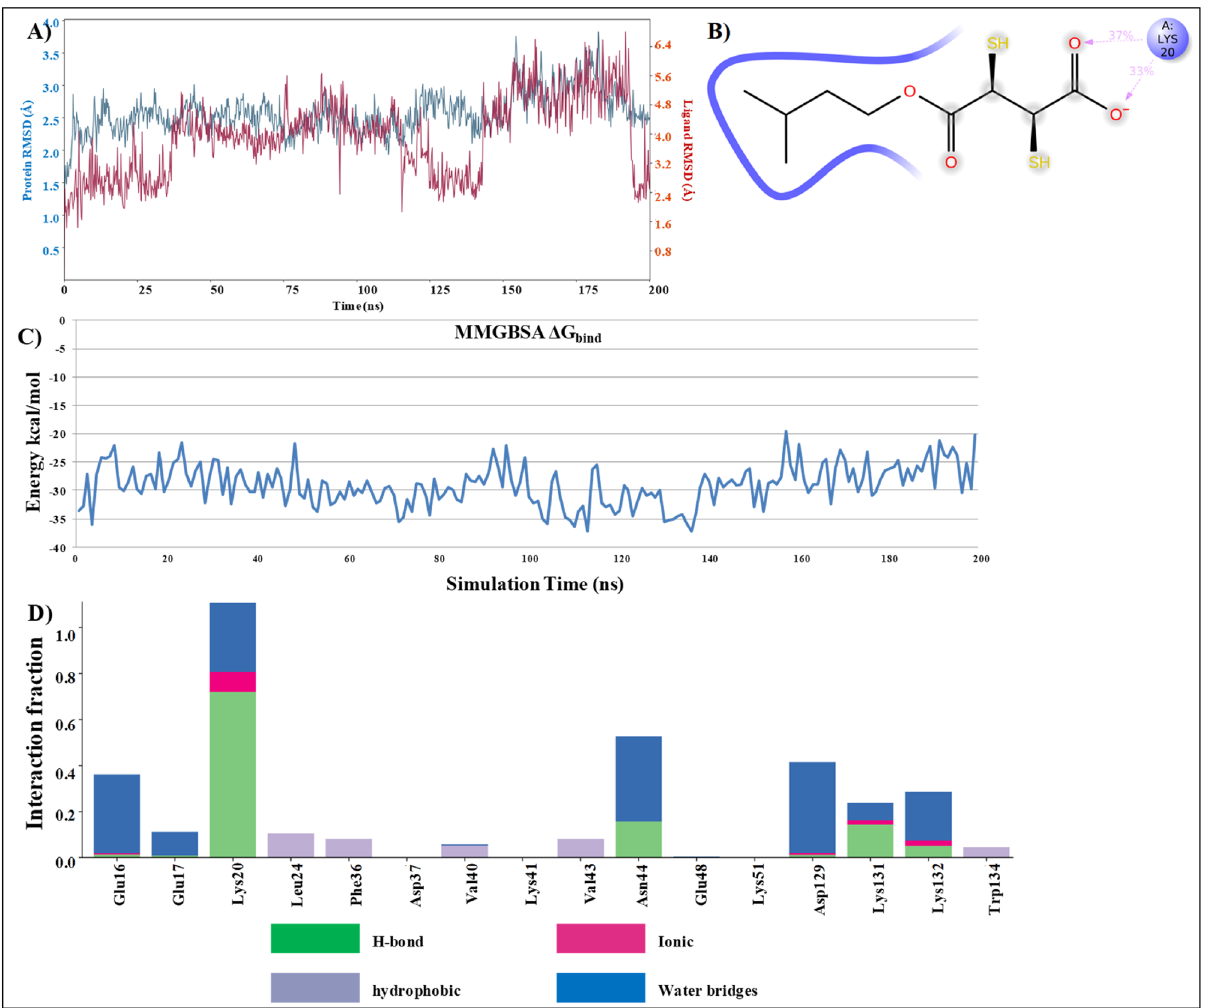
Figure 13. Molecular dynamics result for site II b ( A ) RMSD of protein and ligand ( B ) BSA-MiADMSA interaction diagram during 200 ns of MD simulation ( C ) Binding free energy calculation on 200 ns of MD trajectory ( D ) Interacting residues with their interaction fraction throughout the simulation (Desmond Academic license 2018-4, https ://www.schro dinge r.com/citat ions#Desmo